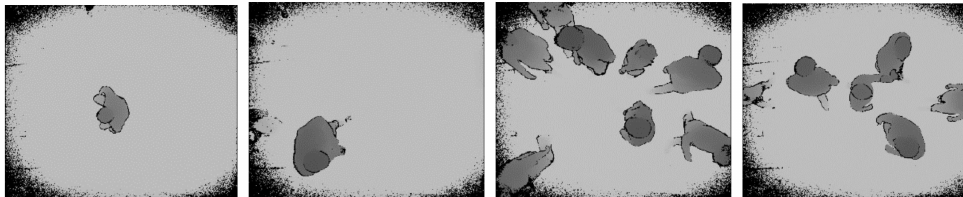
Figure 14. Some examples of the GOTPD dataset.